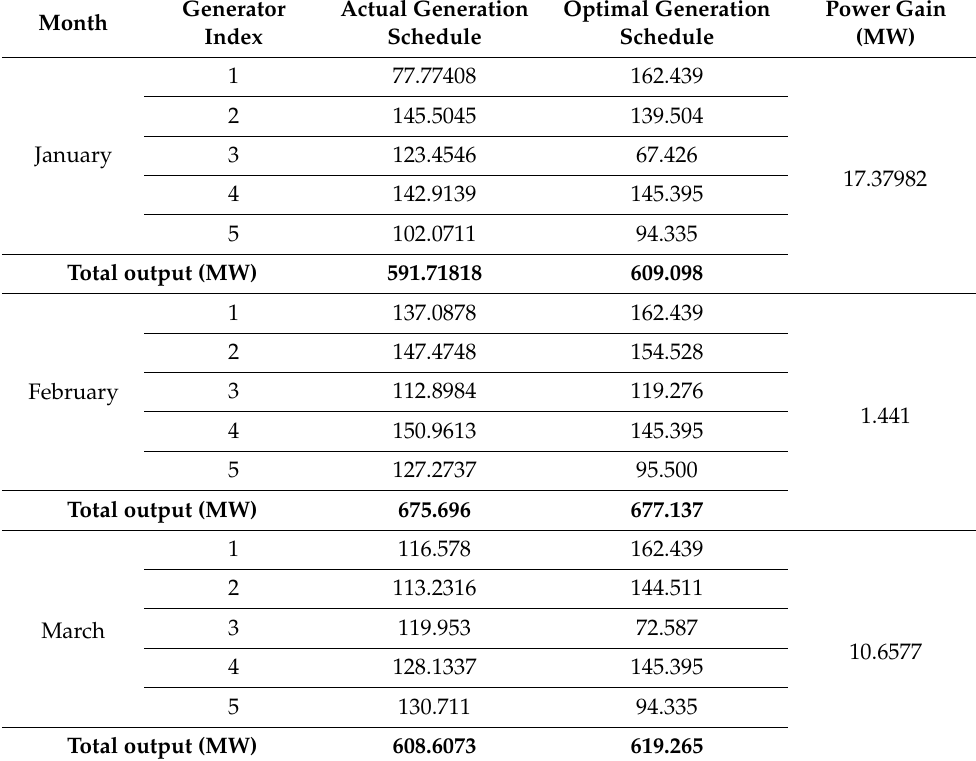
Table 5. Simulation results for a period of nine